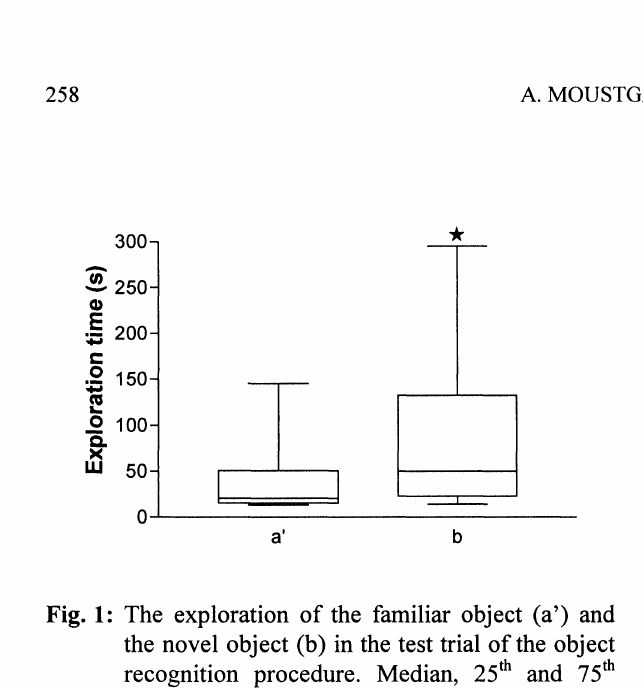
Fig. 1: The exploration of the familiar object (a’) and the novel object (b) in the test trial of the object recognition procedure. Median, 25 th and 75 th percentile, and range are shown. *significantly different from the exploration of the familiar object, p<0.05.